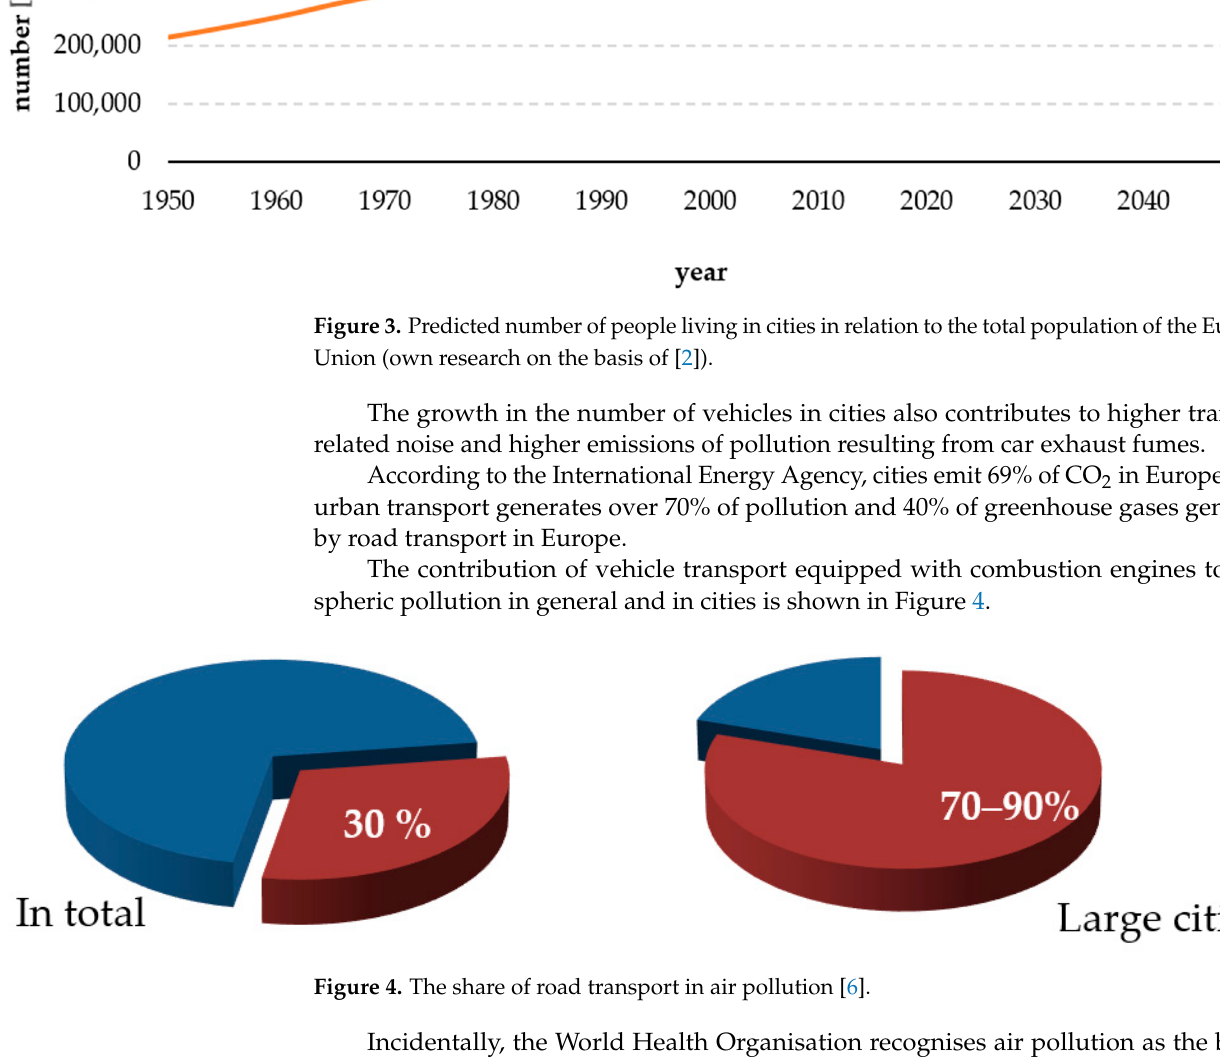
Figure 4. The share of road transport in air pollution [6].